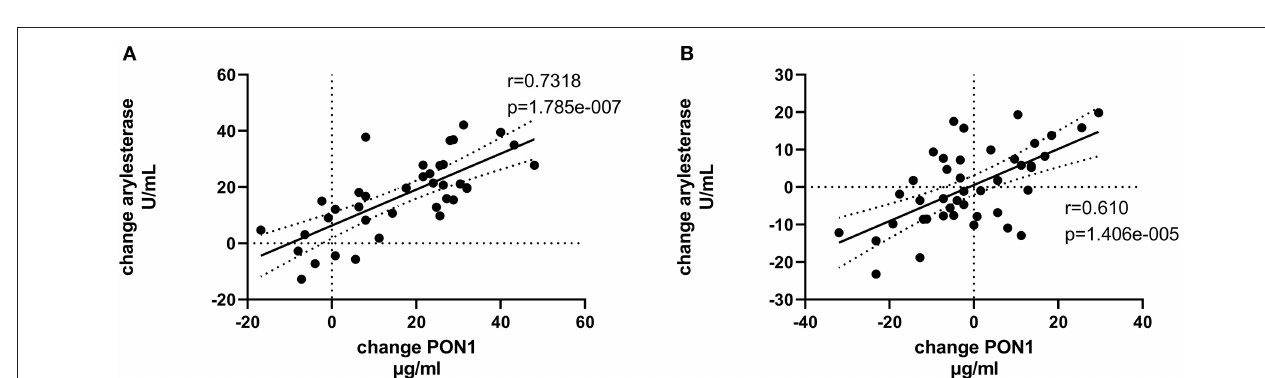
FIGURE 2 | Change in Hb vs. change in PON1 mass. (A) Transplant group. (B) Dialysis group.